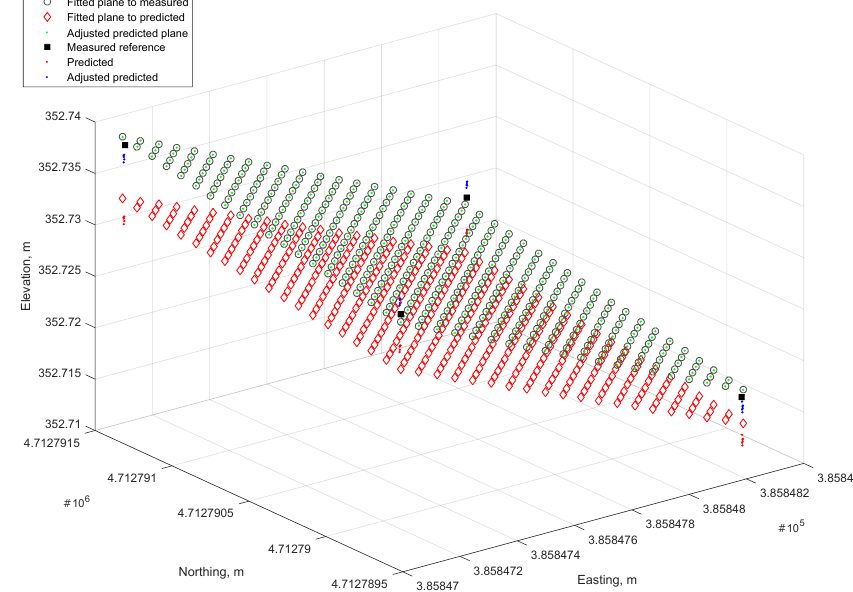
Figure 4. Determination of affine transformation matrices using iterative closest point (ICP)